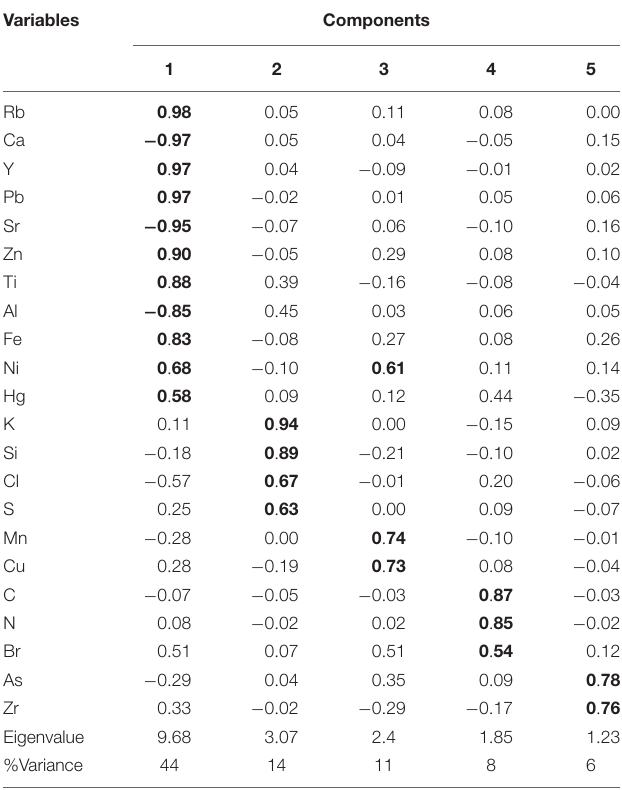
TABLE 3 | Factor loadings for the five significant components extracted by PCA from Amazon Fan sediment samples.